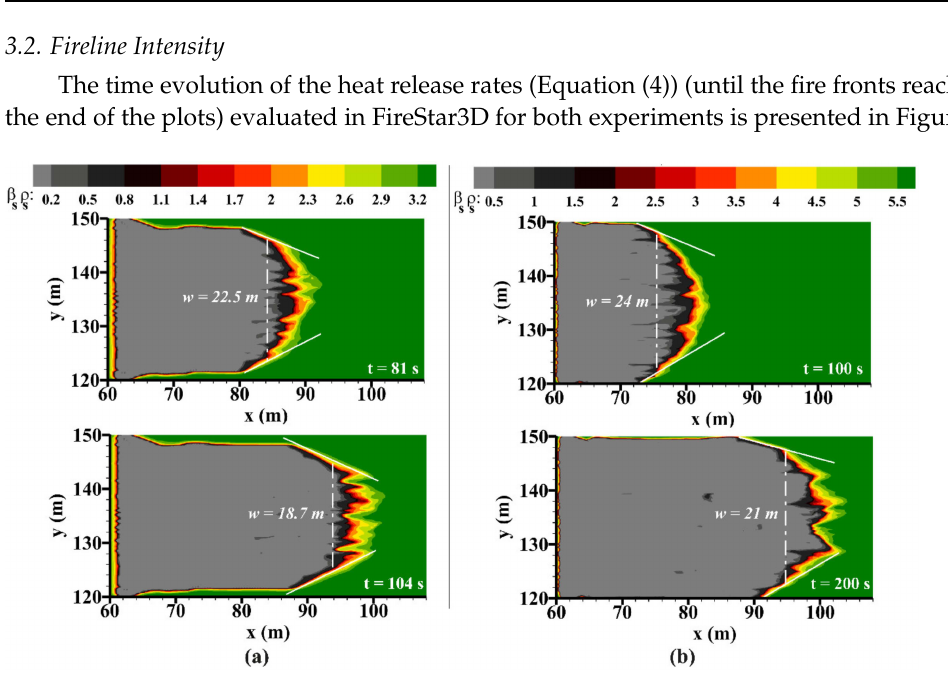
Figure 6. Distribution of the bulk fuel density at the top of the vegetation with the different width of the fire front head corresponding to the maximum and minimum heat release rates (HRR) evaluated for both experiments: ( a ) October 2021 (maximum HRR at t = 81 s; minimum HRR at t = 104 s); ( b ) March 2022 (maximum HRR at t = 100 s; minimum HRR at t = 200